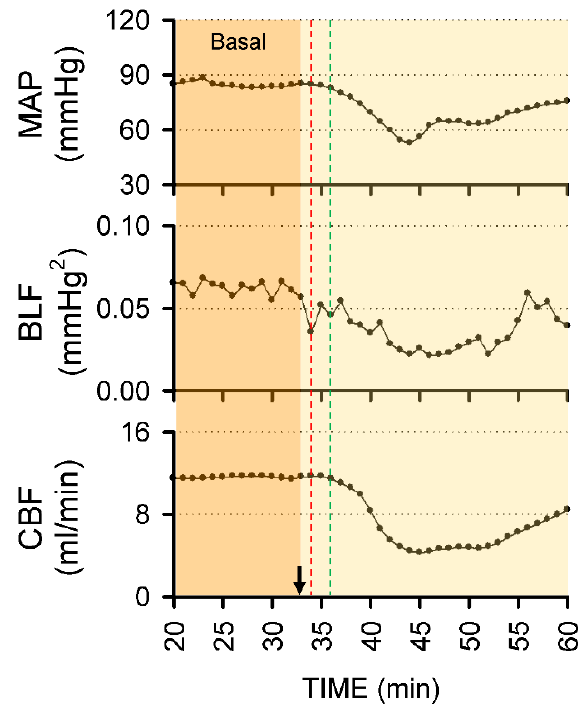
Figure 6. Zoomed-in view of 40 min of real-time recording from Figure 2a of Phase I changes in MAP, BLF and CBF on intrathecal administration of 80 μL of bupivacaine (at arrow). Note that the red and green dotted lines denote time points at which reduction of BLF power and MAP or CBF commenced.